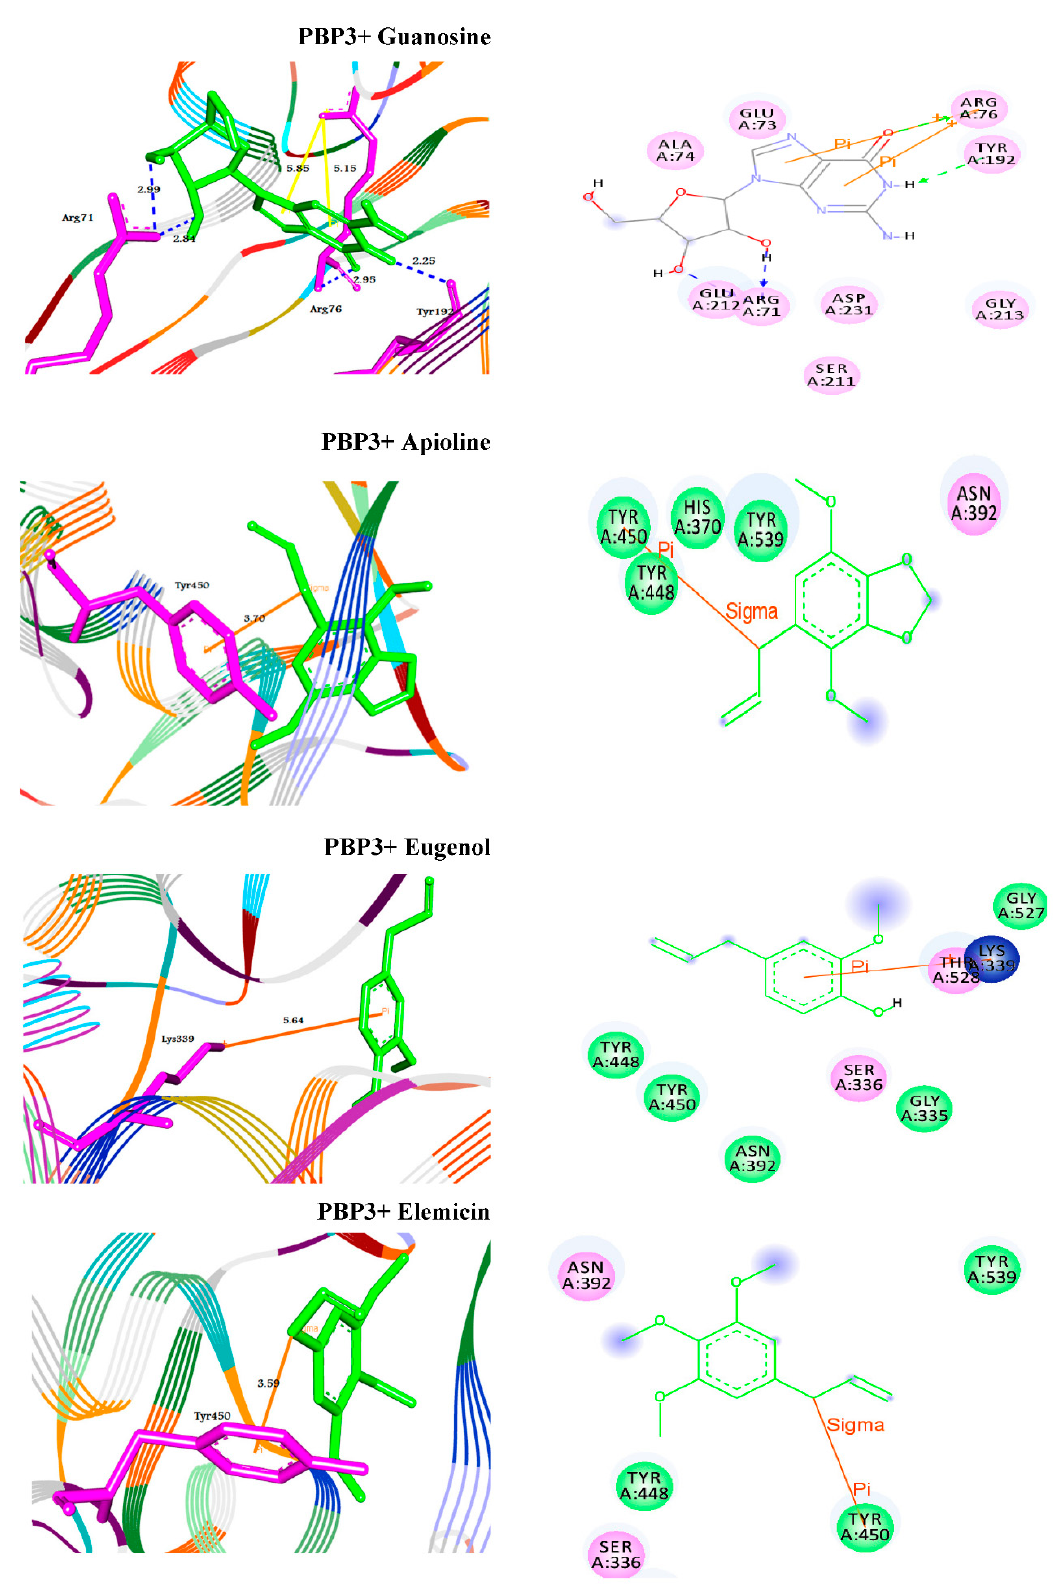
Figure 7. Molecular interactions of Guanosine, Apioline, Eugenol, and Elemicin with penicillin-binding protein 3 (PBP3) in Acinetobacter baumannii . Shown are the 3D ( left ) and 2D ( right ) binding modes upon docking. HBs are represented in blue and green dotted line colors while π - interactions are shown in yellow and orange line colors.